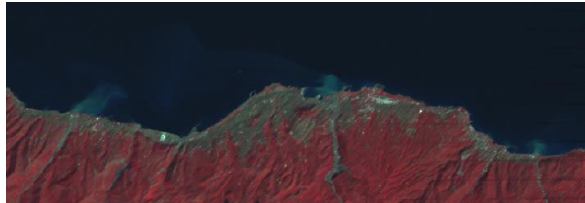
Figure 3. False color composite image - 06.10.2006